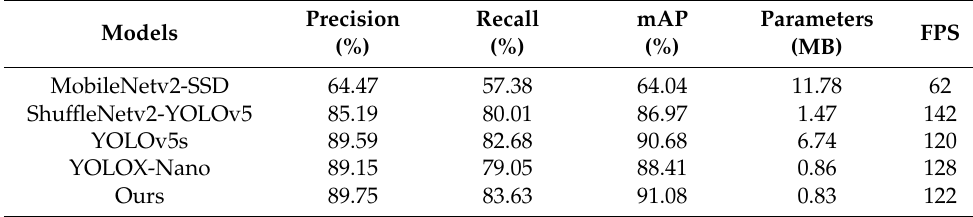
Table 4. Detection results on MSALDD.